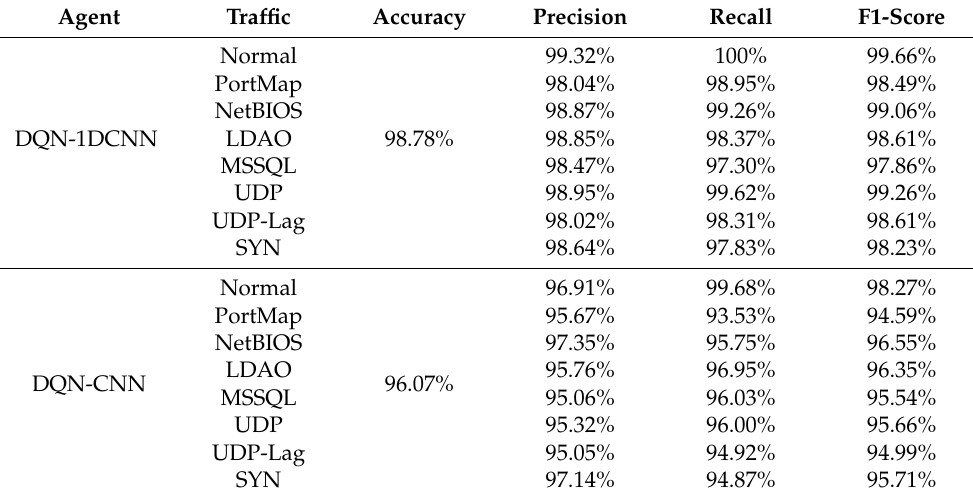
Table 11. Validation results of DQN-1DCNN with discount factor value =